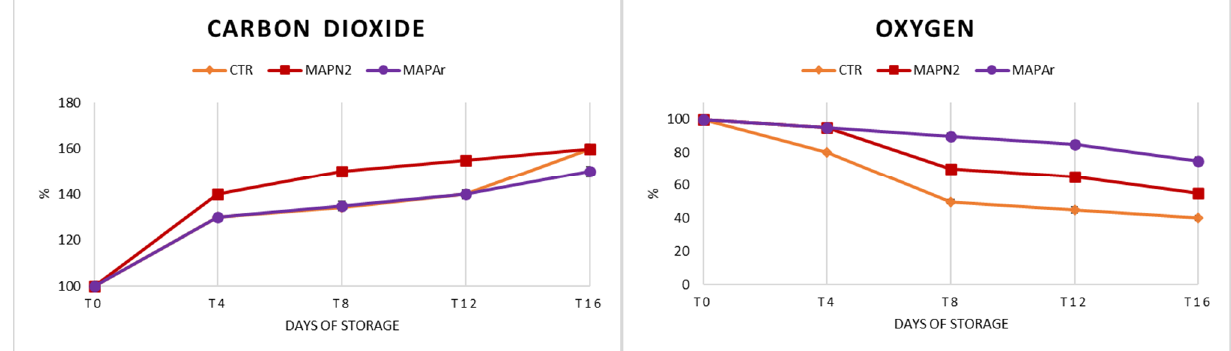
Figure 4. Effect of MAP on the headspace gas concentration (%) during storage (CTR: 20.9% O 2 + 0.04% CO 2 (passive-MAP); MAPN 2 : 10% O 2 + 5% CO 2 + 85% N 2 ; MAPAr: 10% O 2 + 5% CO 2 + 85% Ar). Values were recorded at 0 (T 0 ), 4 (T4), 8 (T 8 ), 12 (T 12 ), and 16 (T 16 ) days at 4 ± 1 ◦ C and 90 ± 5% RH. Data correspond to the means ± SD.